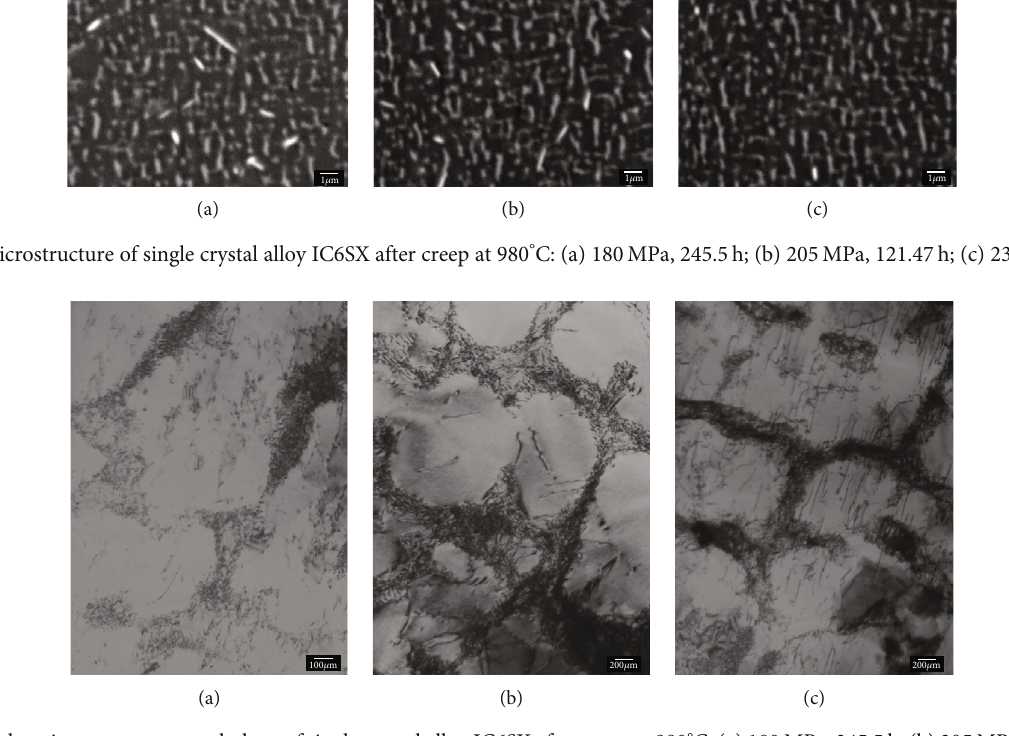
Figure 3: Dislocation structure morphology of single crystal alloy IC6SX after creep at 980 ° C: (a) 180 MPa, 245.5h; (b) 205MPa, 121.47h; (c) 230MPa,